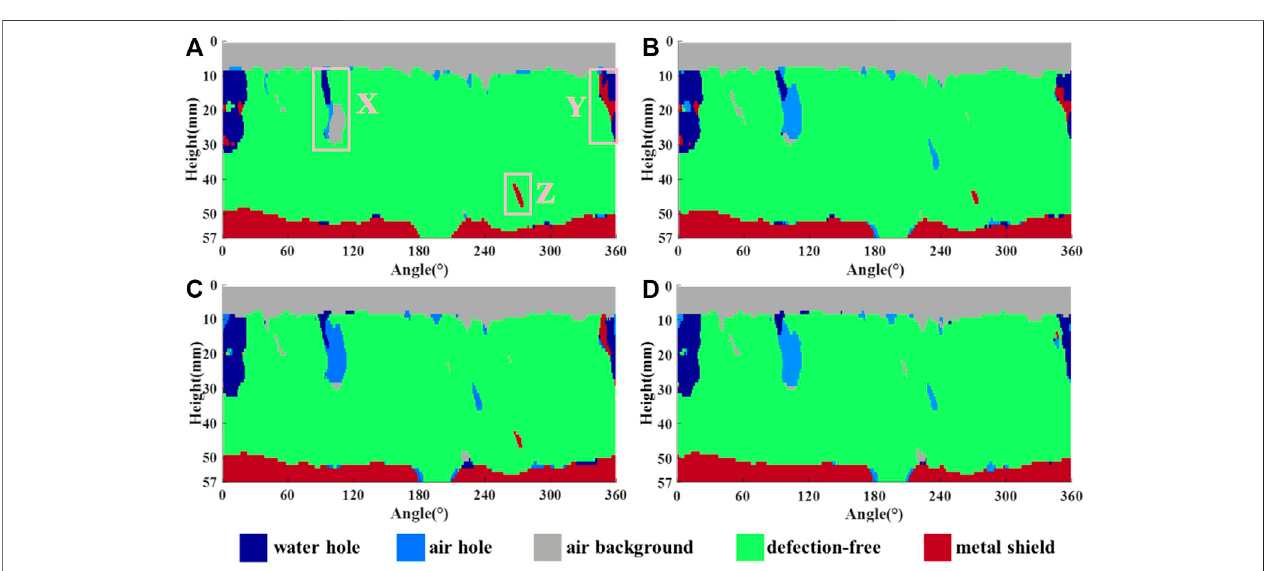
FIGURE10| Distributionimagingofclassi fi cationeigenvaluesfordifferentcumulativevariancecontributionrates. (A) 77.2485%; (B) 84.3089%; (C) 88.2334%; (D) 90.3776%.